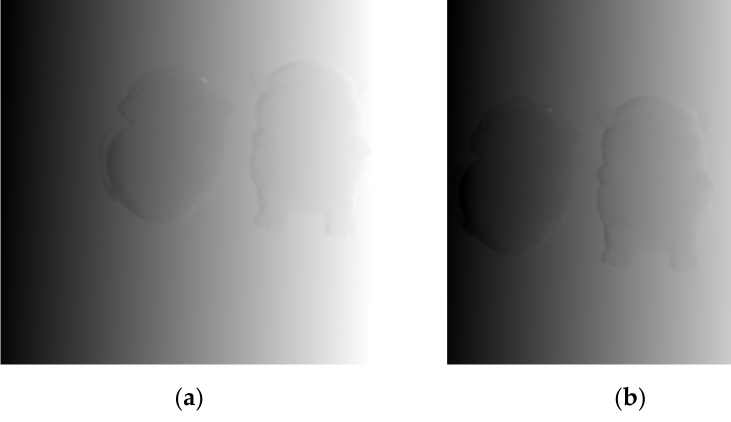
Figure 6. The unwrapped phase maps. ( a ) The original unwrapped phase distribution of low frequency; ( b ) the phase map of ( a ) after position and phase variation compensation; ( c ) the obtained correct unwrapped phase map of high frequency.